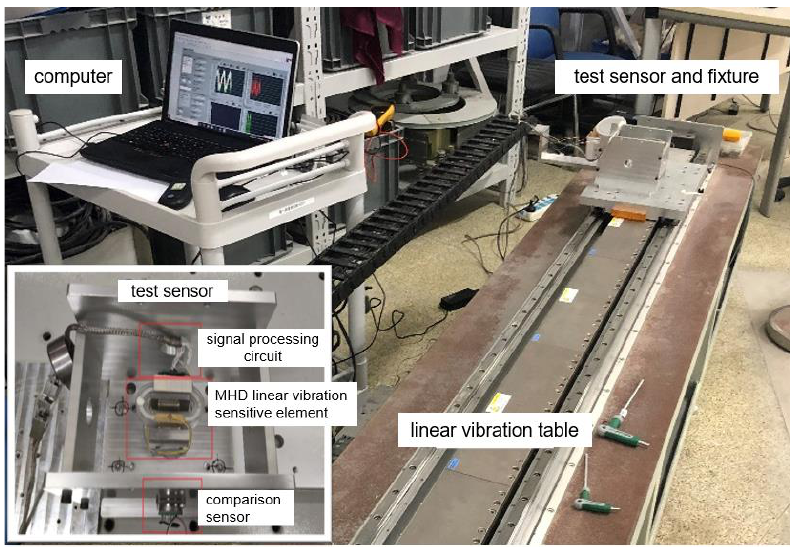
Figure 6. Experimental connection diagram of signal collection of the MHD linear vibration sensor. Four groups of experimental data were collected, including 0.6 V, 10 Hz; 0.6 V, 60 Hz; 0.8 V, 5 Hz; and 0.8 V, 60 Hz, denoted as Collected Signal 1, Collected Signal 2, Collected Signal 3, and Collected Signal 4, respectively. The corresponding spectrum analysis of the four groups of collected signals is shown in Figure 7.